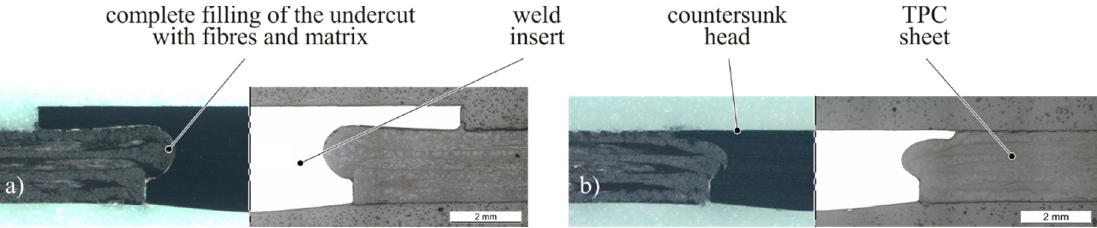
Figure 6. Analysis of the joining zone after embedding: ( a ) type A, ( b ) type B.